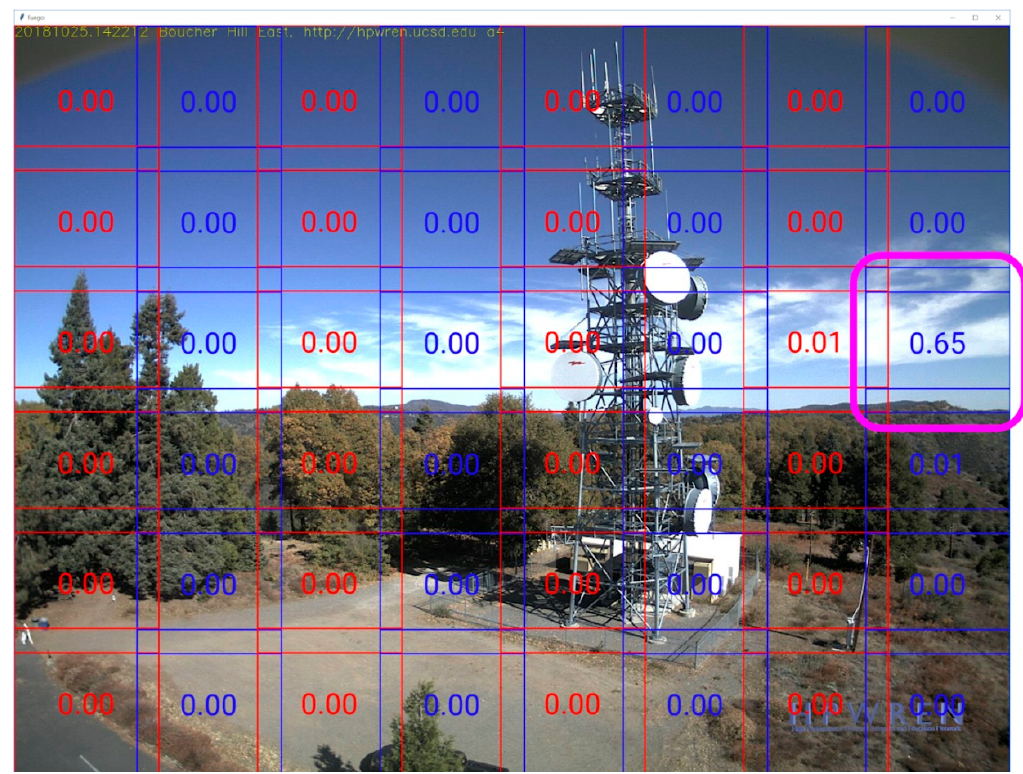
Figure 5. False negative, where smoke in highlighted segment is not detected. Our hypothesis is that this event resembles fog.